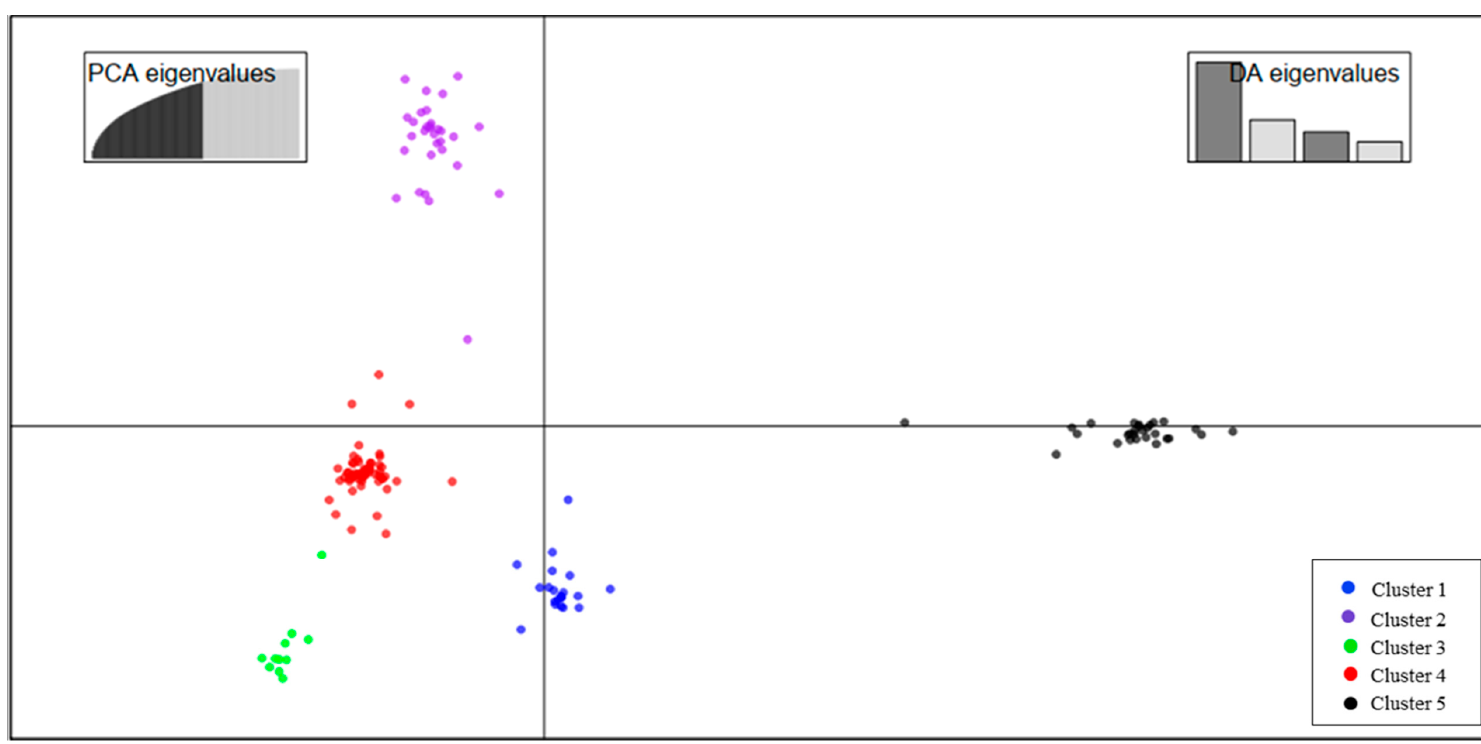
Figure 3. Discriminant analysis of principal component (DAPC) using 16,735 SNP markers. The axes represent the first two linear Discriminant. Each color represents a cluster, and each dot represents an inbred line. Each color represents the different subpopulations identified by DAPC analysis.